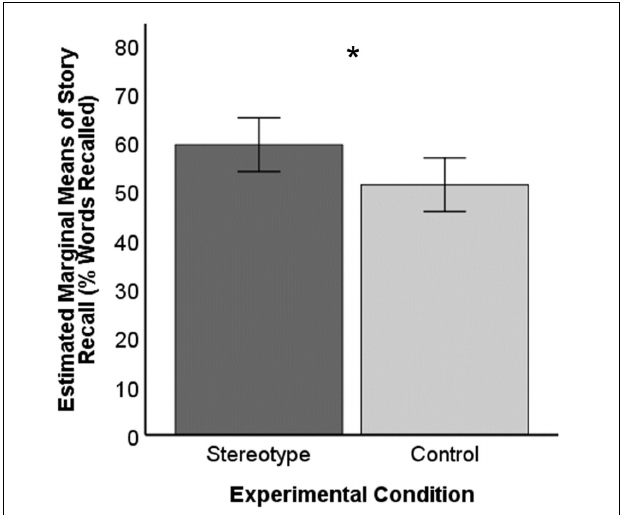
FIGURE 1 | Story recall performance by condition. Error bars represent 95% confidence intervals. Covariate age (in years) evaluated at 63.12. * Indicates significant mean difference, p < .05.